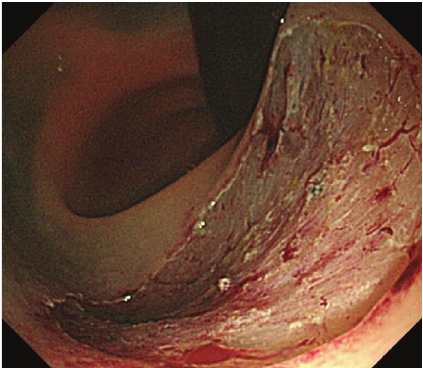
Figure 1: Conventional view of a 0-IIa + IIc lesion located in the rectosigmoid colon. A definite depressed margin and irregular red- dened surface of depression suggested submucosal deep invasion.